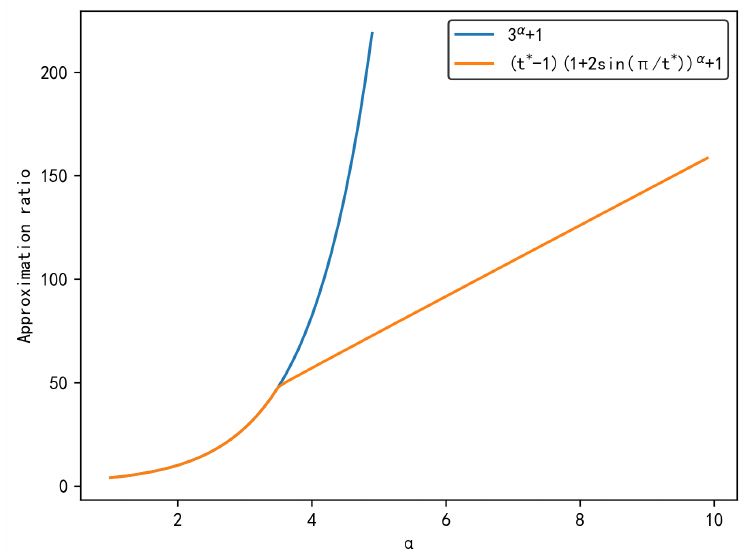
Figure 2. Comparison of two approximate